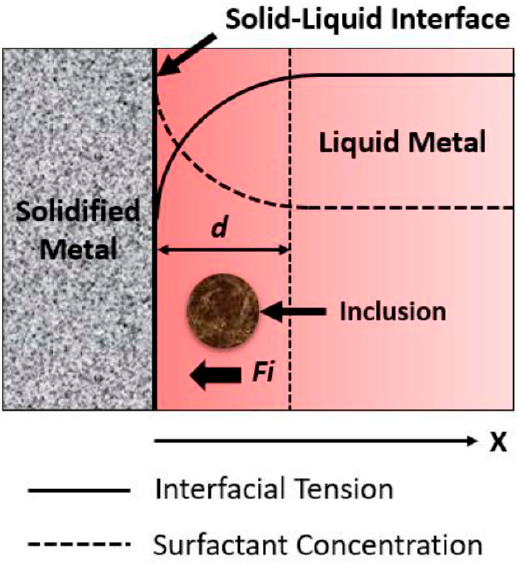
Figure 8. The effect of Marangoni force on an inclusion near the solidifying front.